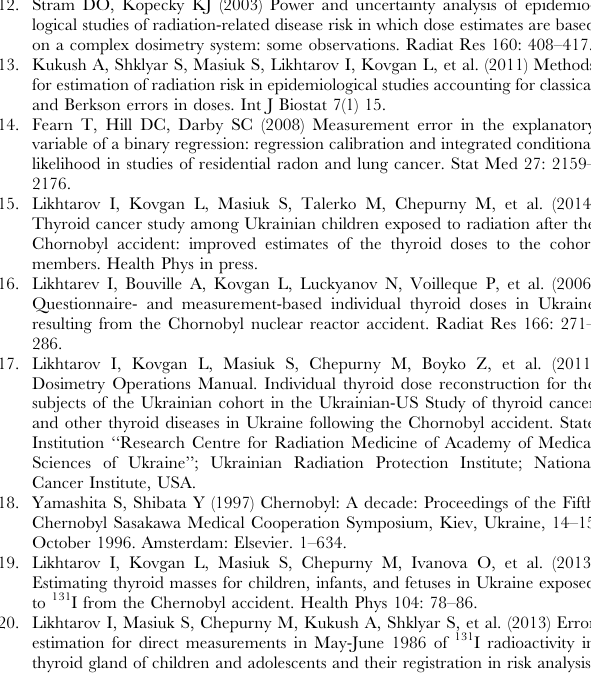
Figure S3 Quantile-quantile plot for ln[current (TD-10) dose] data. (TIFF)